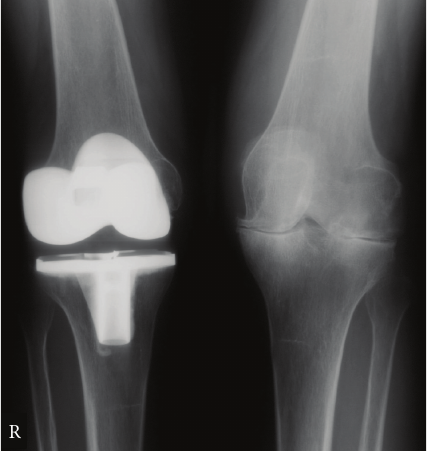
Figure 3: The same patient from Figures 1–3, now 22 months after right TKA was performed. The PA radiographs are seen with improvedjointalignmentintherightknee. Thepatientisdoingwell, walking without pain in the right knee, and is now being considered for a left TKA.